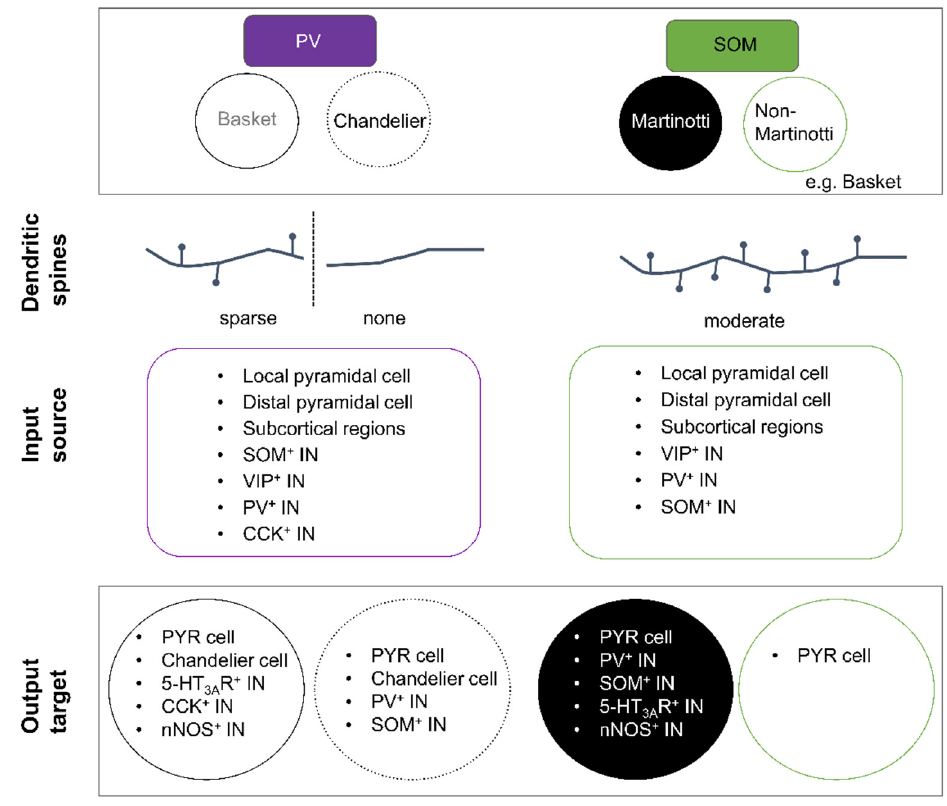
Figure 4. Overview of connectivity (presynaptic inputs and postsynaptic outputs) of neocortical PV + and SOM + INs. PV + INs are subdivided into basket and chandelier cells, and SOM + INs are subclassified into Martinotti and non-Martinotti cells. Dendritic spines can be found on PV + basket cells and on Martinotti and non-Martinotti cells. Dendrites of chandelier cells are always aspiny. The main input source onto any IN type represents pyramidal neurons but PV + and SOM + INs also receive inhibitory inputs from other INs. Main output targets of any IN type are pyramidal cells followed by other IN types.